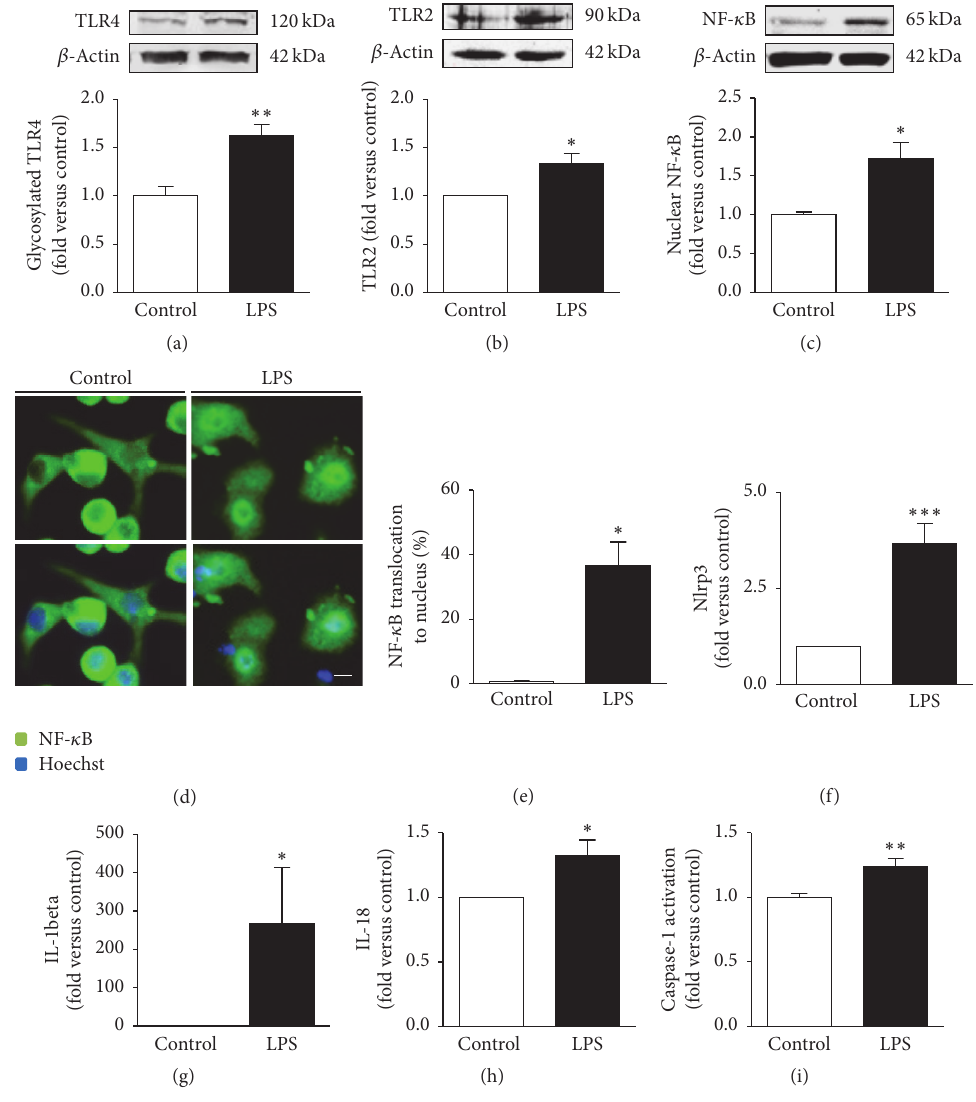
Figure 5: M1 polarized N9 microglia evidence activation of TLR4/TLR2/NF- 𝜅 B signaling pathway and of inflammasome complex. Protein expression of glycosylated toll-like receptor 4 (TLR4) (a) and TLR2 (b) was evaluated by Western blot analysis. Translocation of nuclear factor kappa B (NF- 𝜅 B) to the nucleus is represented by considering the Western blot analysis of nuclear expression (c). To observe NF- 𝜅 B cellular localization, immunocytochemistry against anti-NF- 𝜅 B was performed as indicated in Materials and Methods and representative results are shown (d) and presented as the percentage of cells with nuclear staining versus total number of cells (e). NOD-like receptor family, pyrin domain containing 3 (Nlrp3) , interleukin- (IL-) 1beta, and IL-18 expression were measured by qRT-PCR ((f), (g), and (h), resp.). Detection of caspase-1 activation was achieved by a colorimetric assay, as described in Materials and Methods (i). Results are mean ± s.e.m. from six (a, c), five (f, g, h), four (b), or three (e, i) independent experiments; (c) and (i) were performed in duplicate. Comparisons between lipopolysaccharide- (LPS-) treated N9 cells and nontreated cells (control) were made via two-tailed Student’s 𝑡 -test for all the parameters, except for (c, e), where unpaired 𝑡 -test with Welch’s correction was applied. ∗ 𝑝 < 0.05 , ∗∗ 𝑝 < 0.01 , and ∗∗∗ 𝑝 < 0.001 versus nontreated cells (control). Scale bar represents 20 𝜇